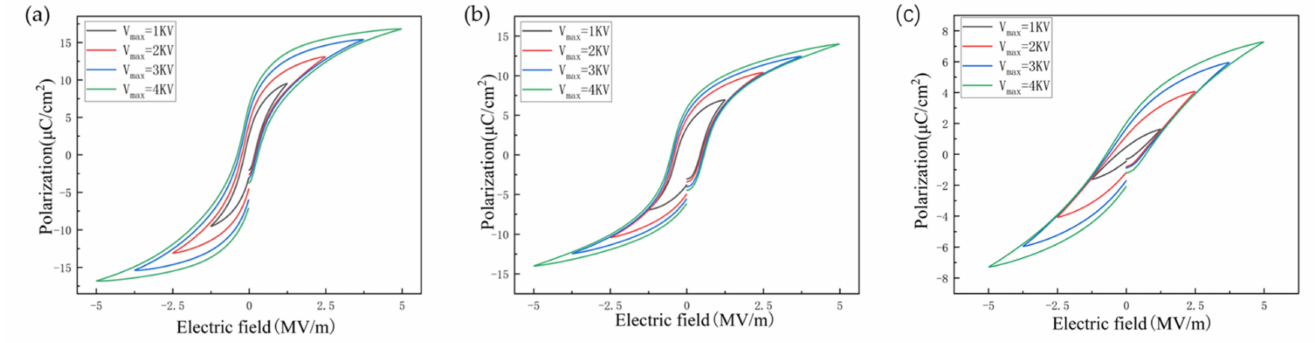
Figure 3. Polarization-electric-field (PE) hysteresis loops of Ba 1 − x Ca x TiO 3 : ( a ) x = 0, ( b ) x = 0.1, ( c ) x = 0.4 ceramics.